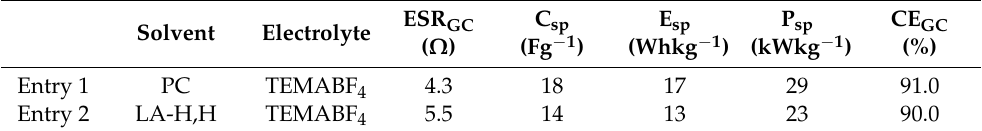
Table 3. GC results at 0.5 Ag − 1 normalized with total mass of electrodes active materials.